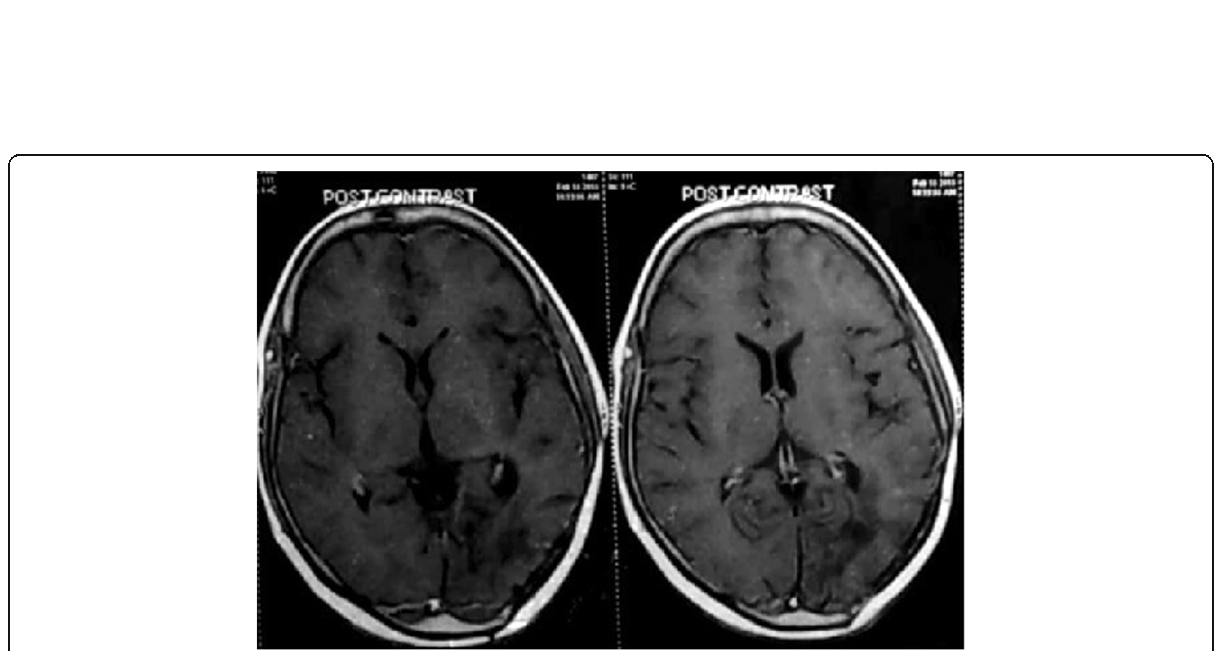
Fig. 5 CEMRI brain T1 contrast image done after 14 months of surgery showing post radiotherapy changes with no